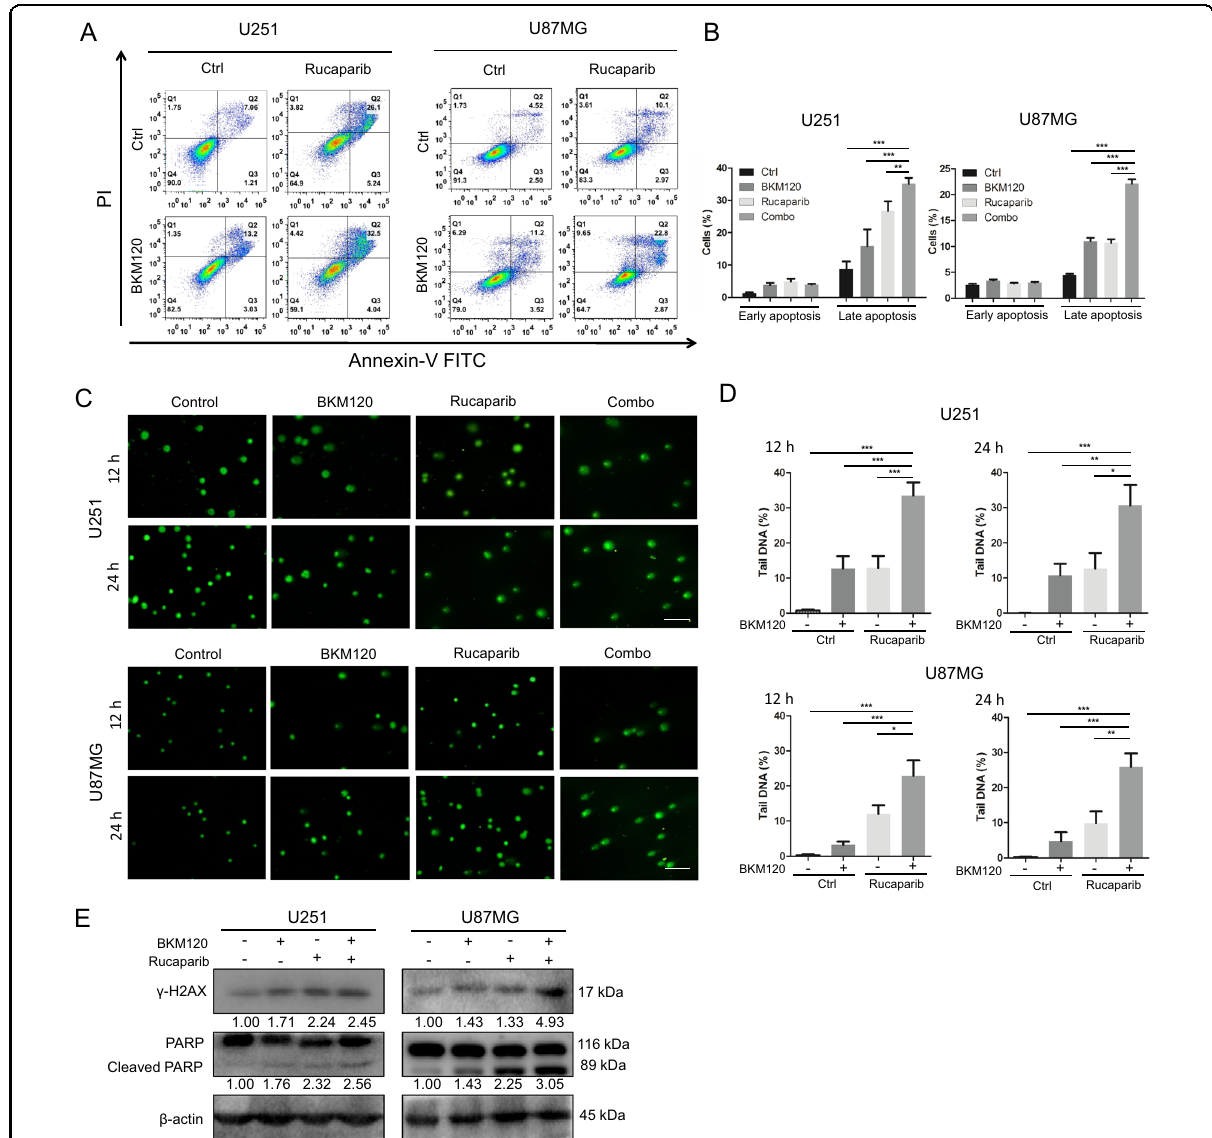
Fig. 2 BKM120 and rucaparib cooperate to induce apoptosis and DNA damage in GBM cells. U251 and U87MG cells were treated with BKM120 and rucaparib as single agents or in combination. A The percentage of apoptotic cells was determined by Annexin V and PI staining at 72 h. B FACS quanti fi cation of the respective cell population including Annexin V + /propidium iodide − early apoptotic cells, and Annexin V + /propidium iodide + late apoptotic cells. C DNA damage in GBM cells was determined by alkaline comet assay to detect both SSBs and DSBs for 12 and 24 h. Comet images × 200 acquired by fl uorescence microscopy are shown. Scale bar: 100 μ m. D The tail moment was used to quantify DNA damage with CASP software. E The expression levels of the apoptosis marker PARP (cleaved and full length) and the DNA DSB marker γ -H2AX were determined by western blotting at 48 h. All data are presented as the mean ± SD ( n = 3). * P < 0.05; ** P < 0.01; *** P <